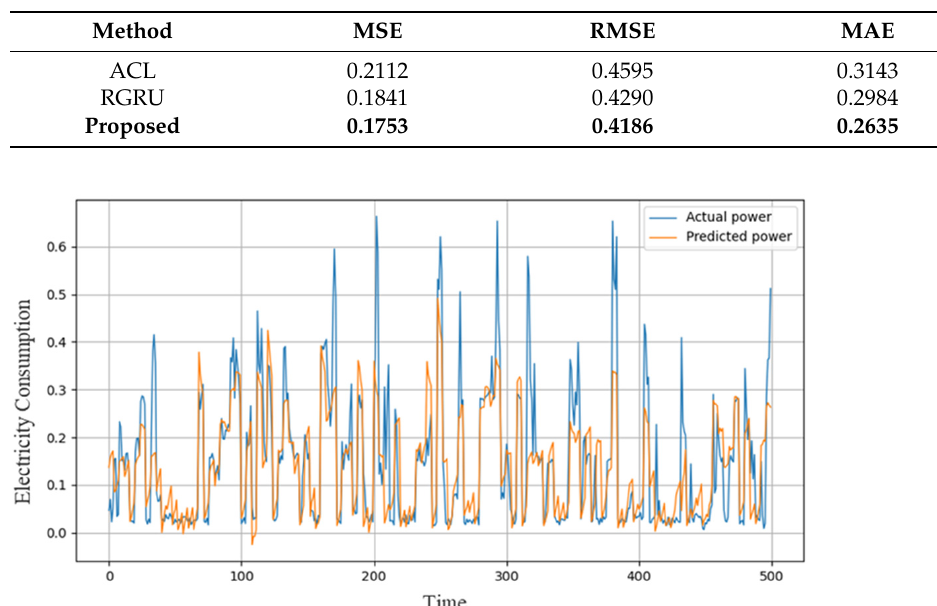
Figure 7. Performance of the proposed model over IHEPC dataset.